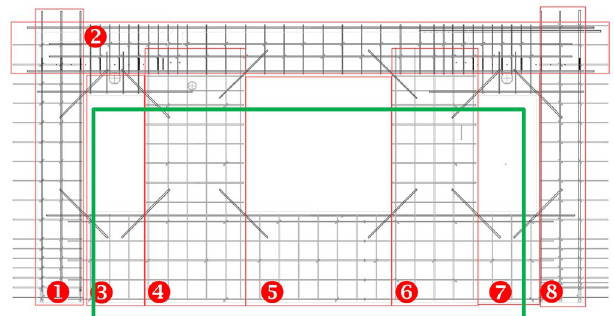
Figure 4. Module composition in PC